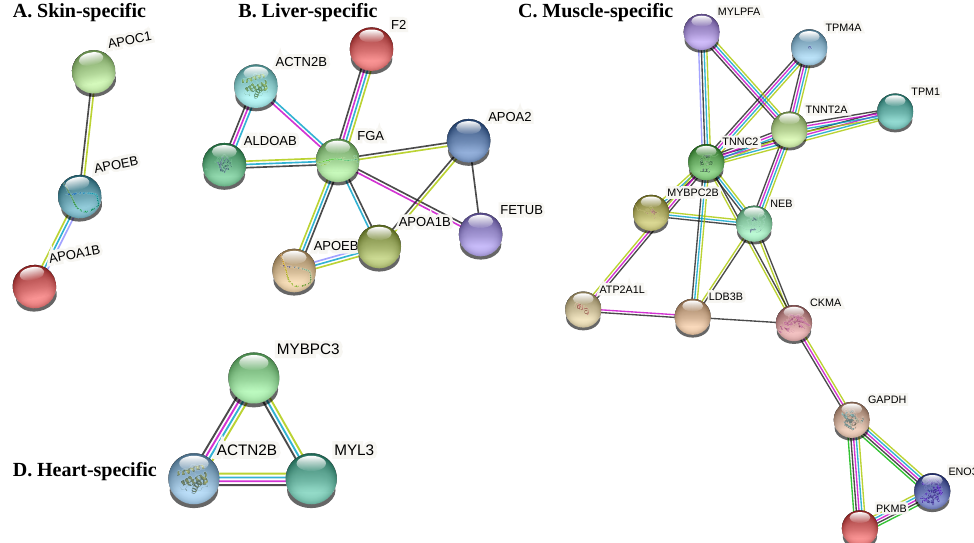
Figure 6. Tissue specific protein–protein interaction networks predicted in four pikeperch tissues including skin, liver, muscle and